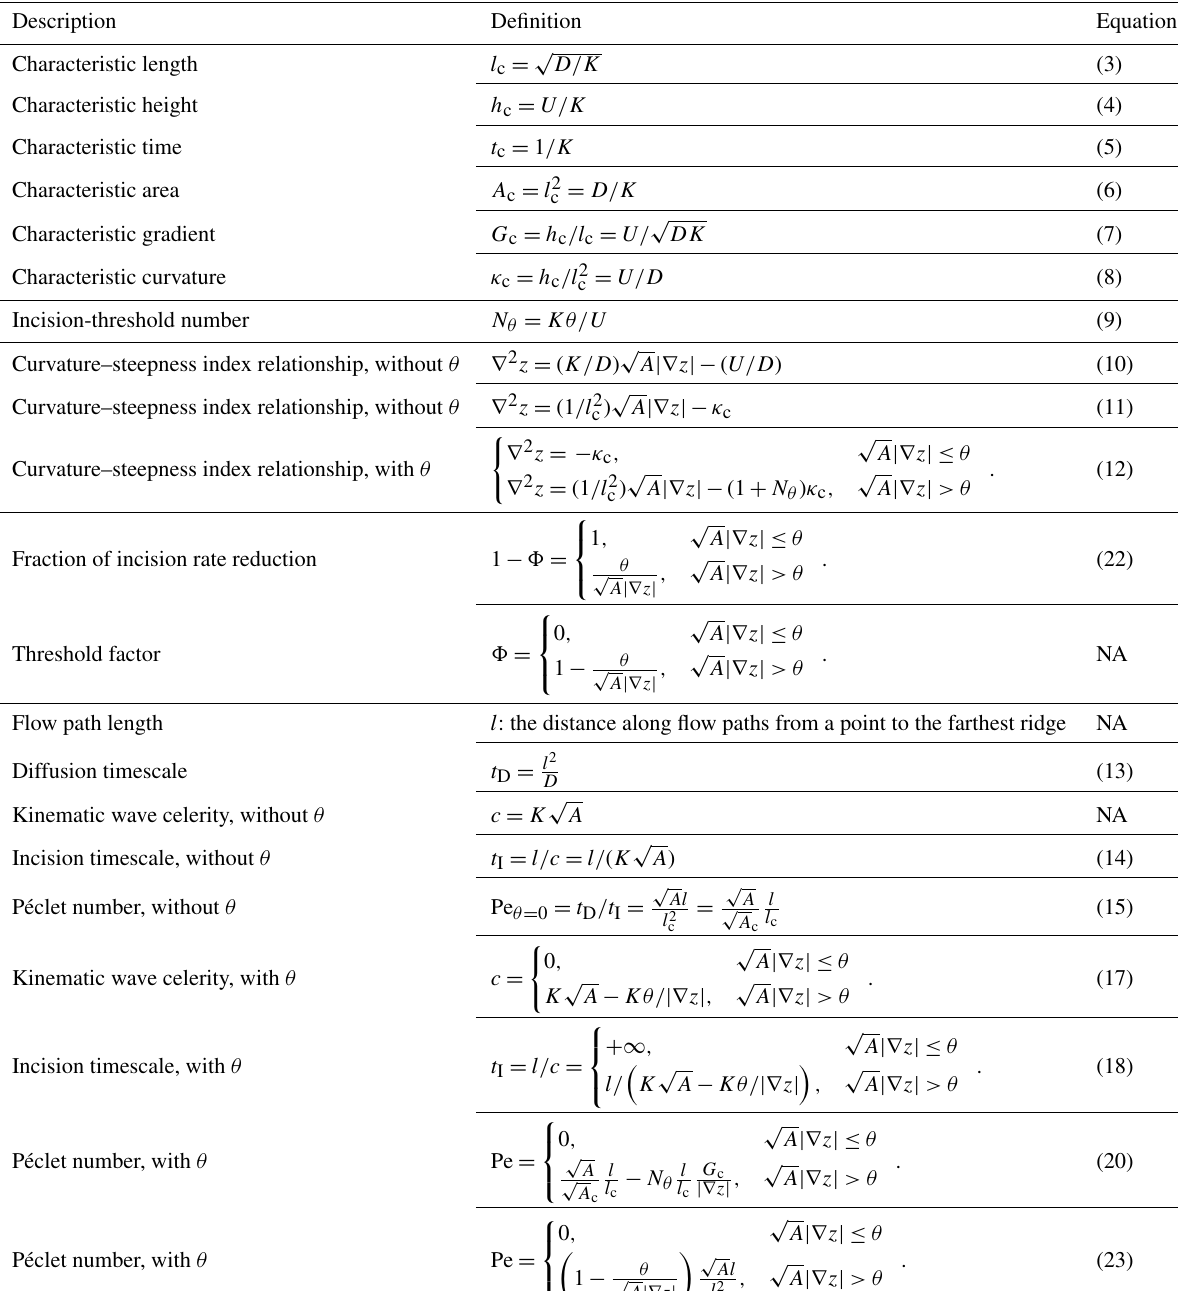
Table 2. Summary of definitions and formulas used in this